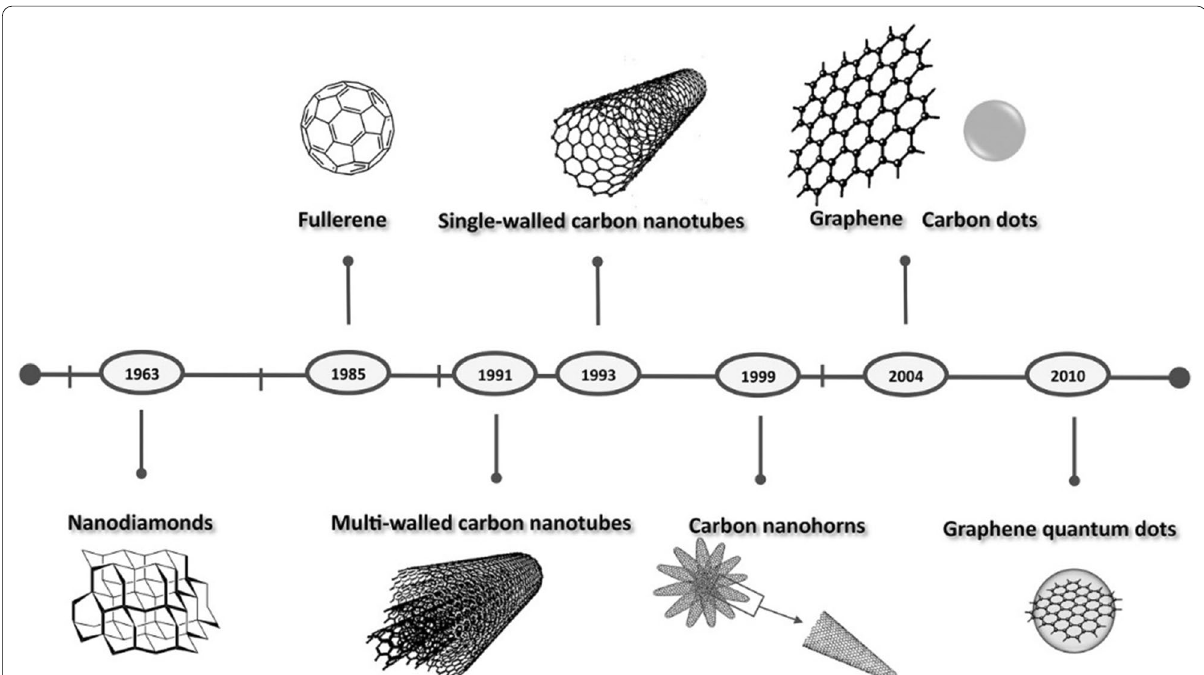
Fig. 3 The major milestones in the development of carbon-based nanomaterials [85]. Reproduced with permission. Copyright © 2020 WILEY ‐ VCH Verlag GmbH & Co. KGaA,